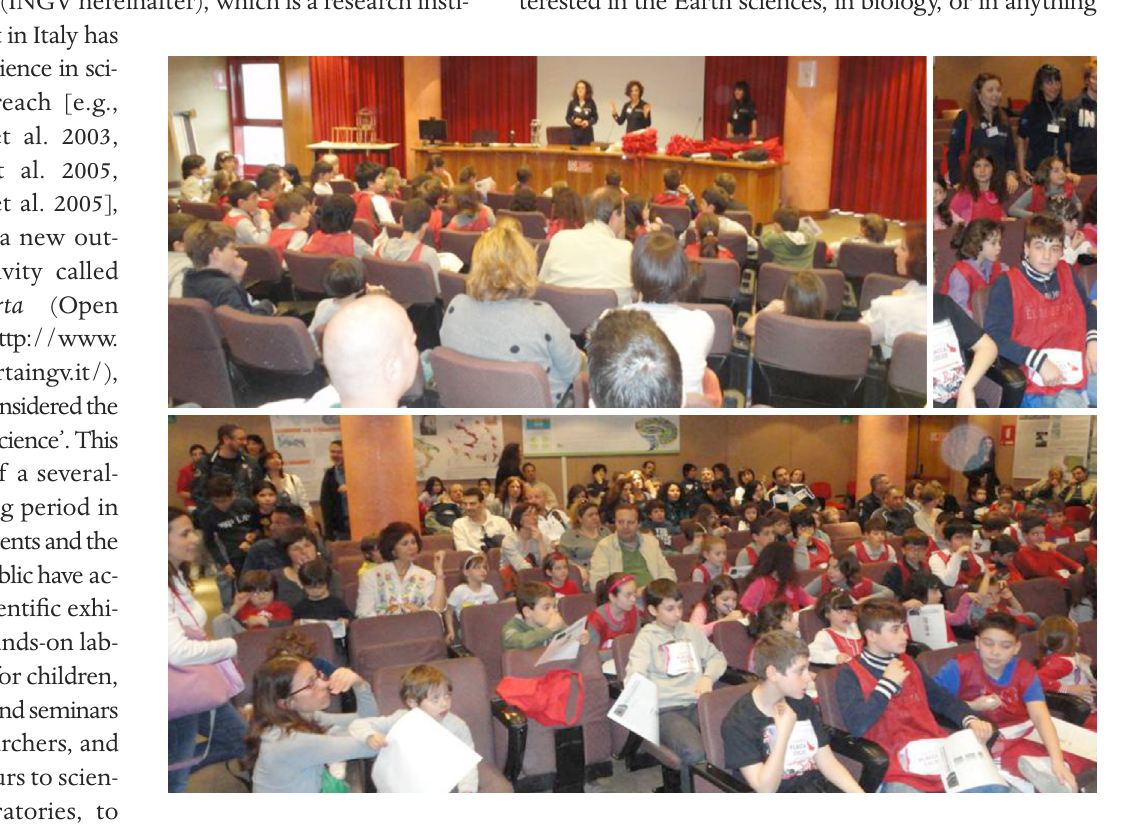
Figure 1. The award winner ceremony at the INGV congress hall in Rome during ScienzAperta